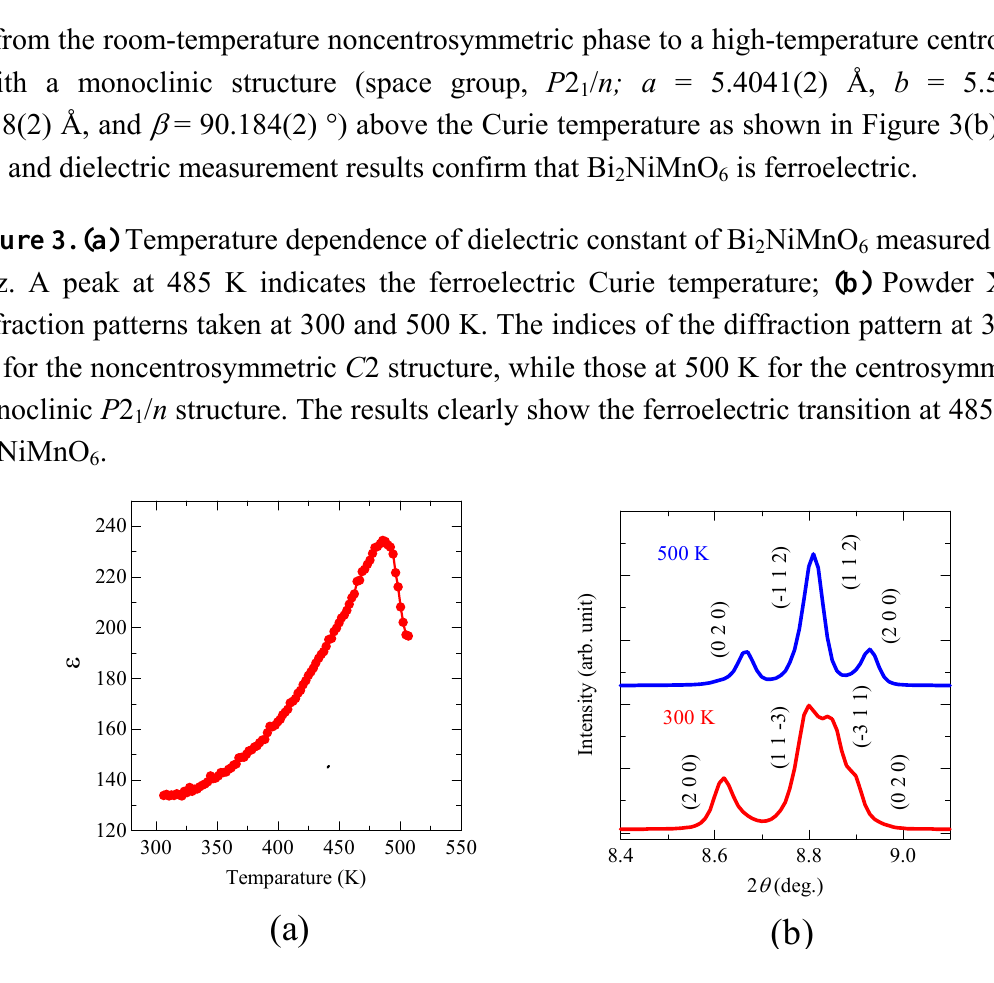
NiMnO measured at 10 2 6